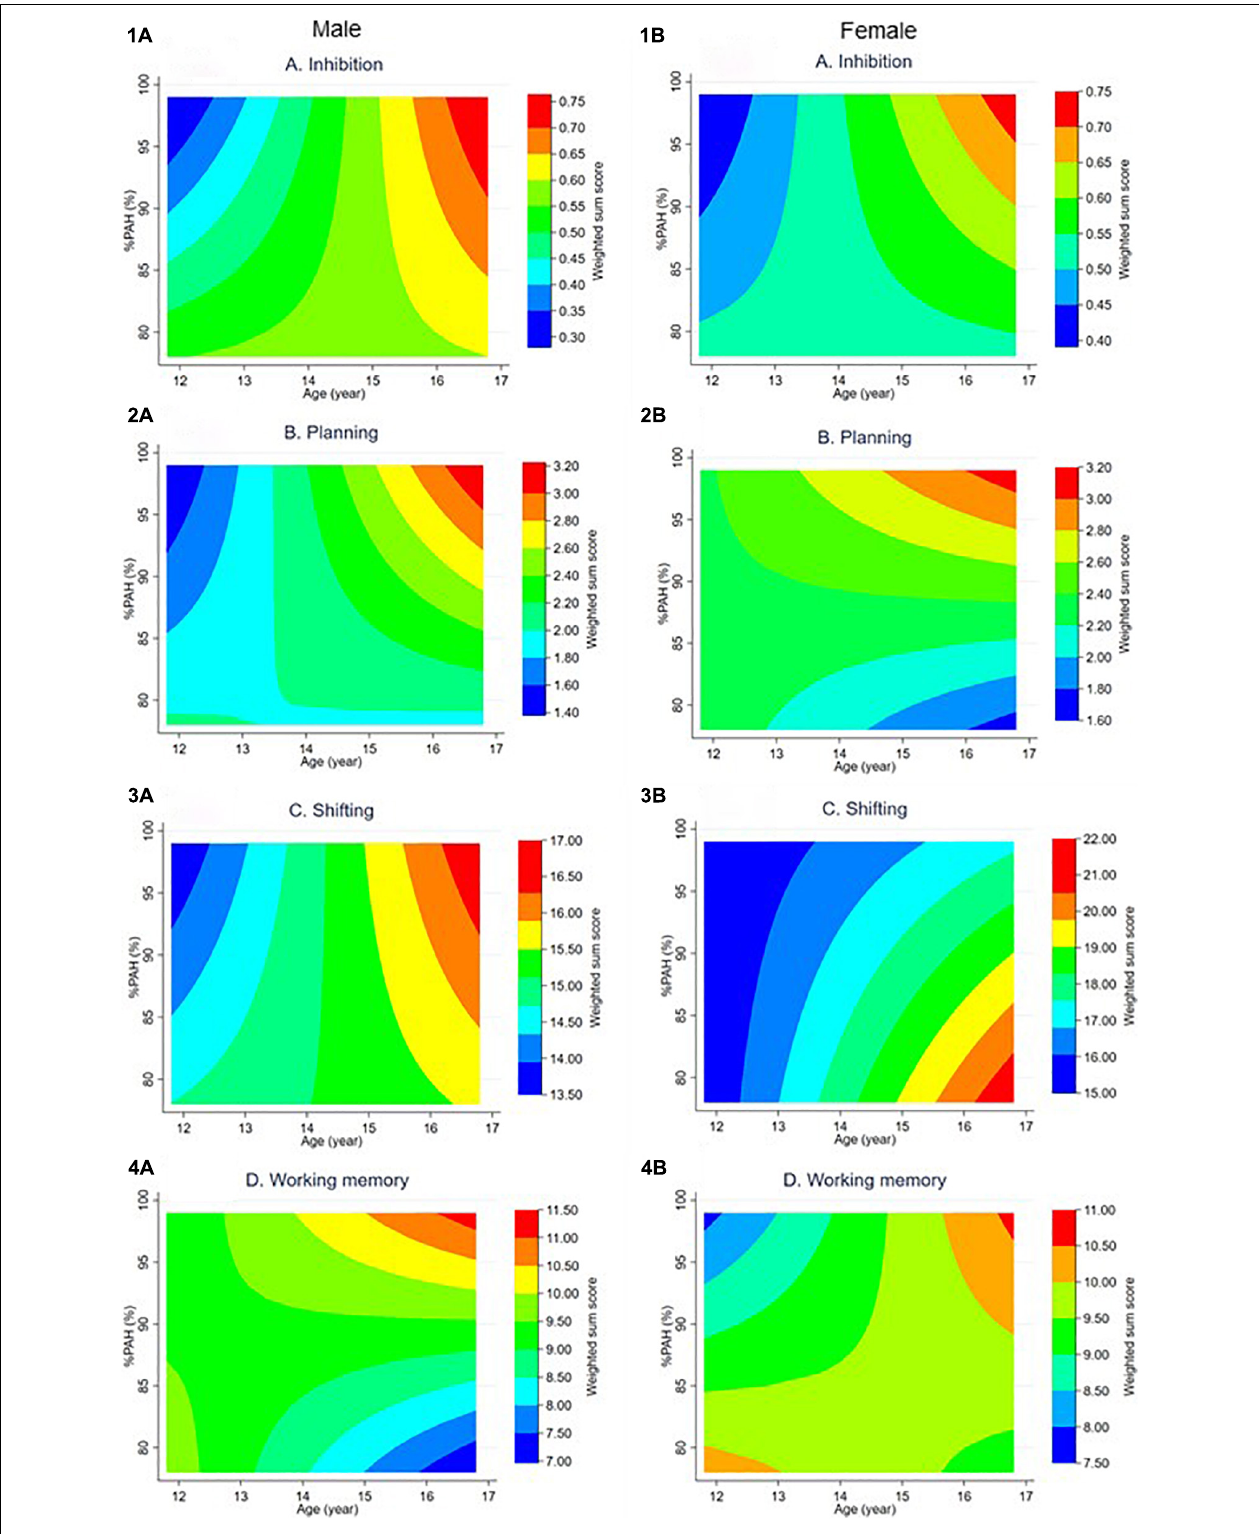
FIGURE 3 | Prediction plots based on the interaction between age and %PAH in GEE model 3 per sex (A = male, B = female), for each EF component (1 = Inhibition, 2 = Planning, 3 = Shifting, 4 = Working memory). On the x-axis, age is portrayed and, on the y-axis, %PAH. EF performance is divided in seven equal intervals, going from the lowest (blue color) to highest (red color) score on the particular EF component. %PAH, percentage of predicted adult height.